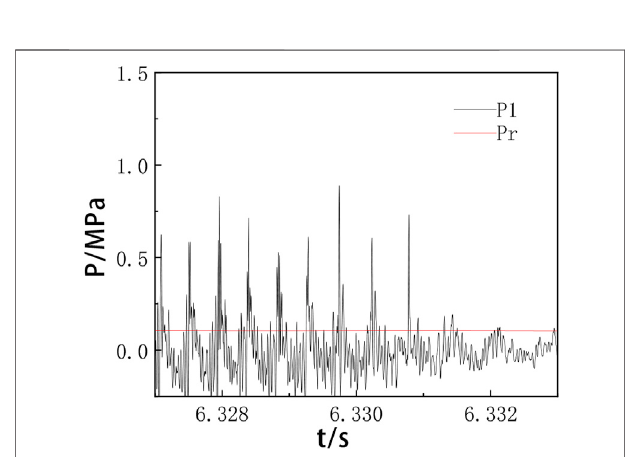
Frontiers in Energy Research |